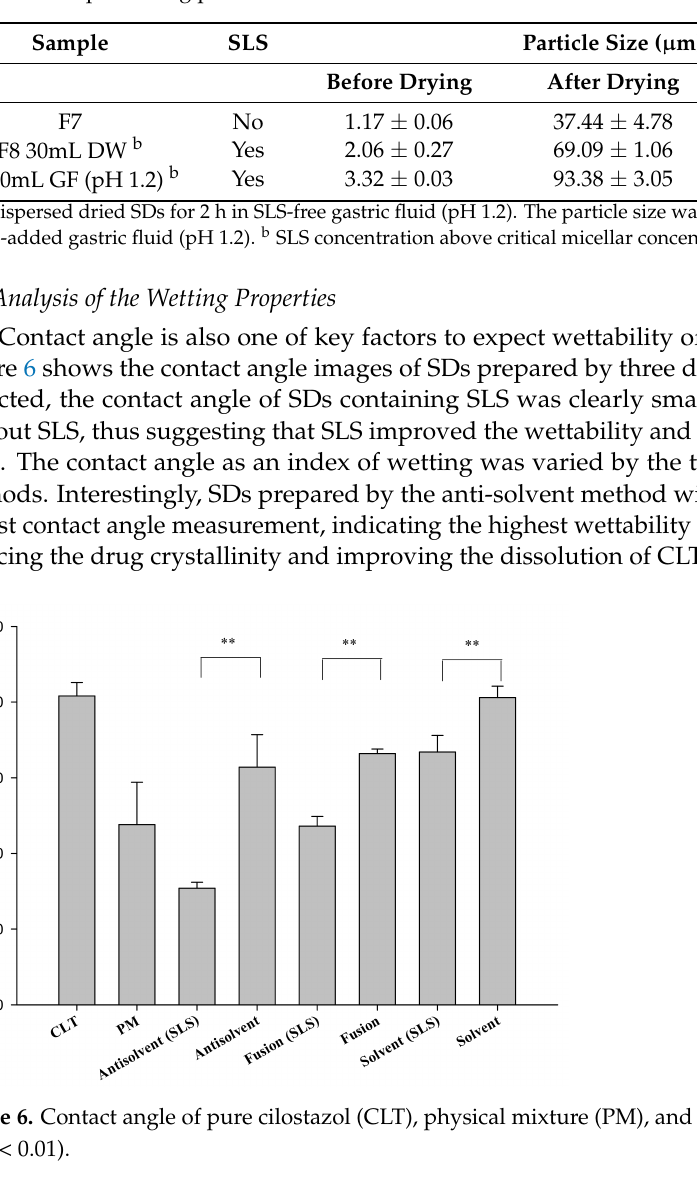
Table 4. The effect of SLS on the particle size (D 50 , µ m) of SDs prepared by the anti-solvent method with different processing periods.